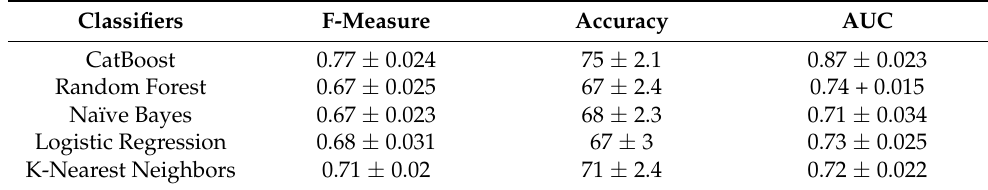
Table 4. Performance scores of various